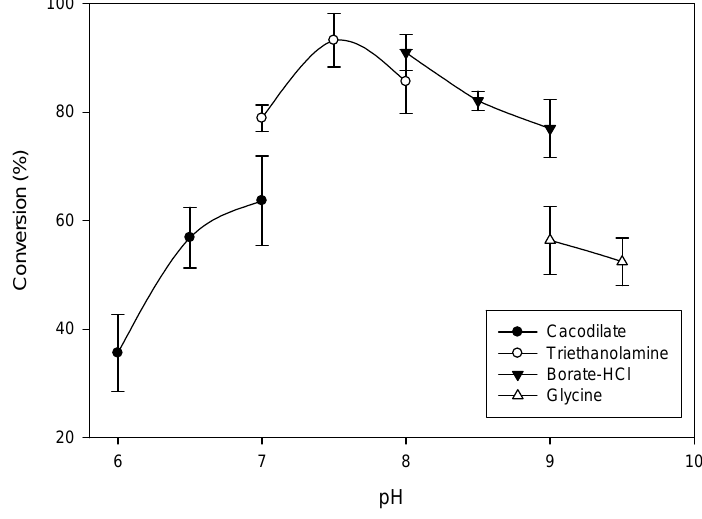
Figure 2. pH optimization using 10 mM D , L ‐ methylthioethylhydantoin as substrate, 100 mM of each buffer (cacodylate, pH 6–7; triethanolamine, pH 7–8; borate, pH 8–9; glycine, pH 9–10) supplemented with 1 mM CoCl 2 , for 4 h at 60 °C with constant stirring. Compounds of the multi ‐ step reaction were separated in HPLC Water with a Zorbax C 18 column, mobile phase of 80:20 20 mM phosphoric acid, pH 3.2, and methanol; 0.4 mL/min, and measurement at λ = 203 nm.